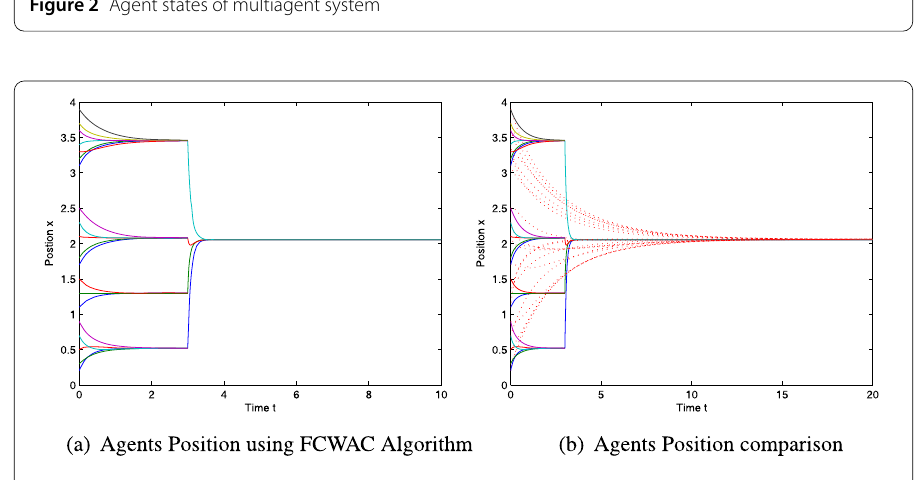
Figure 3 State trajectories of multiagent